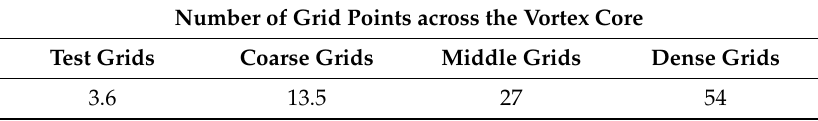
Figure 10. Turbulent kinetic energy and vorticity magnitude for cases using different types of grids; ( a ) test grids; ( b ) coarse grids; ( c ) middle grids; ( d ) dense grids. Table 3. The number of grid points across the vortex core to predict tip-vortex flow.